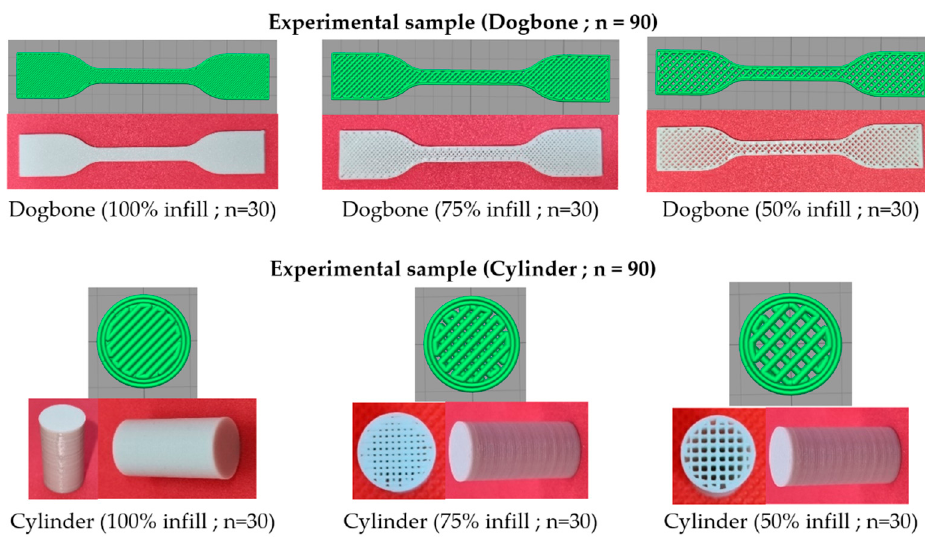
Figure 3. Preprocessing and printing experimental samples for mechanical testing (Cylinder—uni- axial mechanical compressive testing; Dogbone—uniaxial mechanical tensile testing).